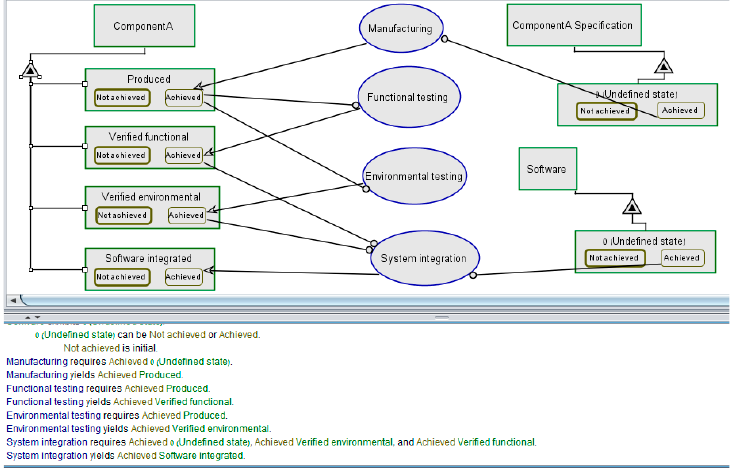
Figure 11. Process description modeled in OPM using PROVE’s Development Process Design (DPD) ontology.